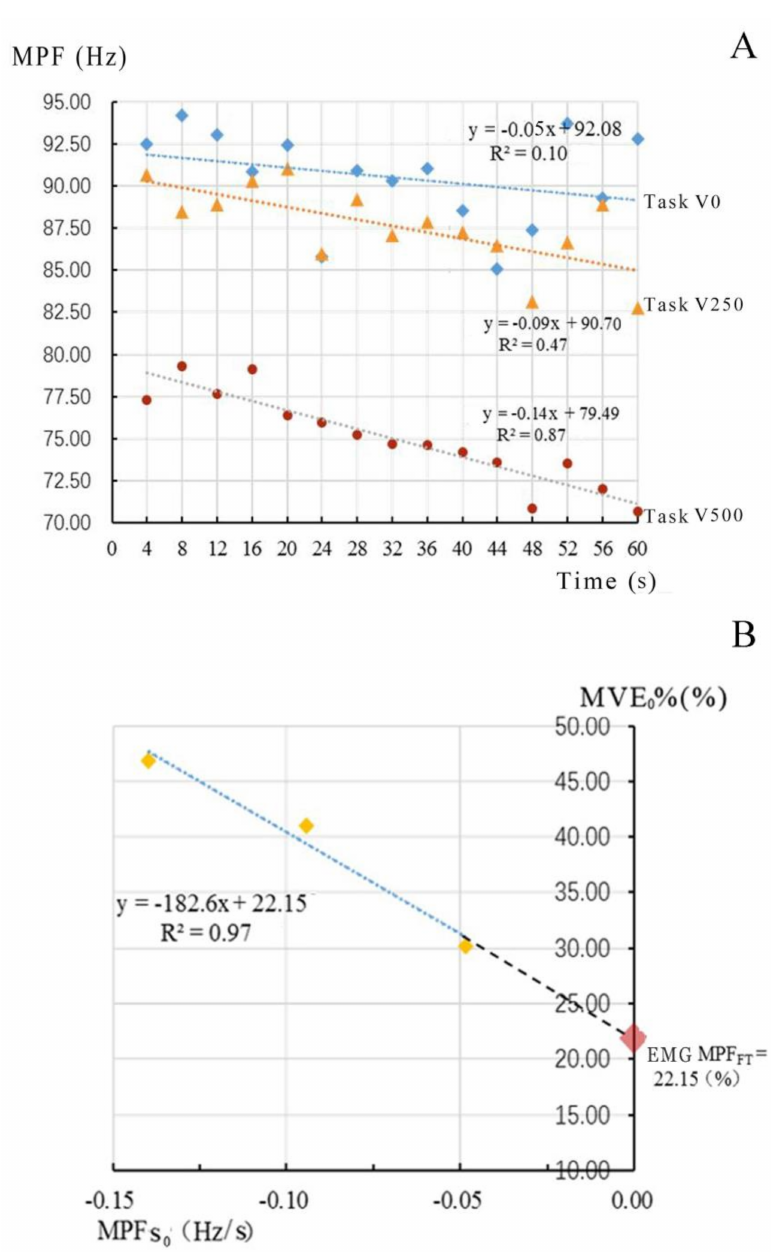
Figure 6. Process of measuring EMG MPFFT from data of the multifidus muscle of subject 8. ( A ) The MPF data (10 sections) were plotted as a function of time (s) for 3 muscle tensions (30.23%, 41.98%, 47.16%MVC in the figure). ( B ) The MPF slope coefficients obtained from ( A ) were plotted versus muscle tension for each test level and the EMG MPFFT was measured as the y − intercept value